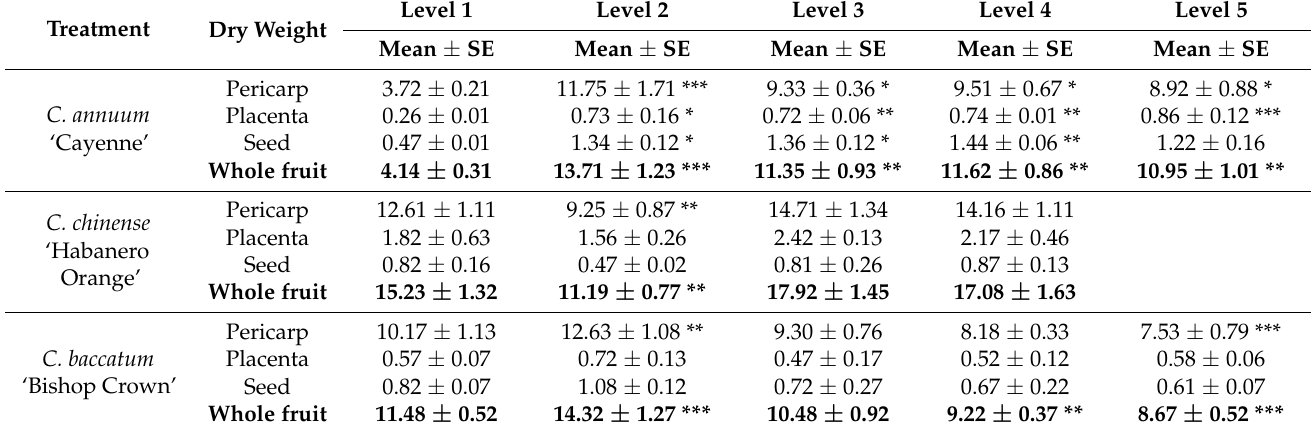
Table 1. Average dry weight of individual fruit parts and whole fruit (g; mean ±